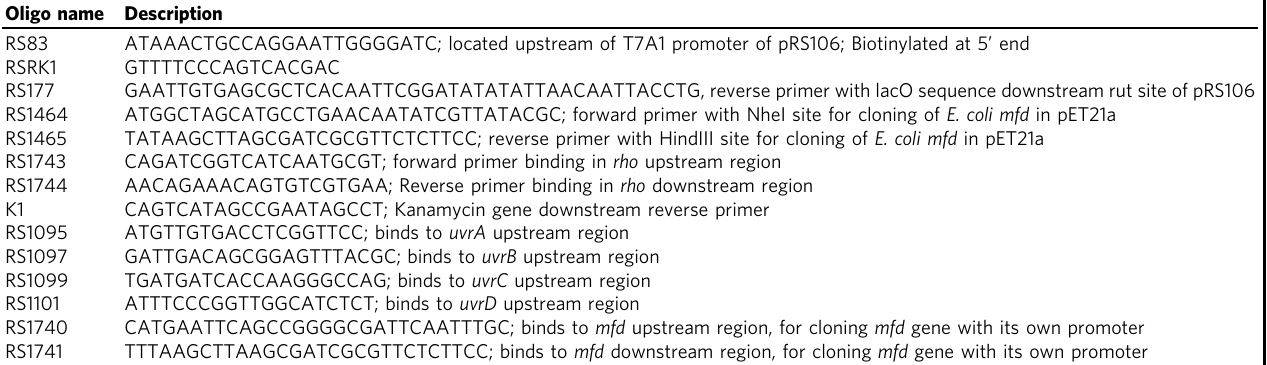
Table 2 Oligonucleotides used in this study Oligo name